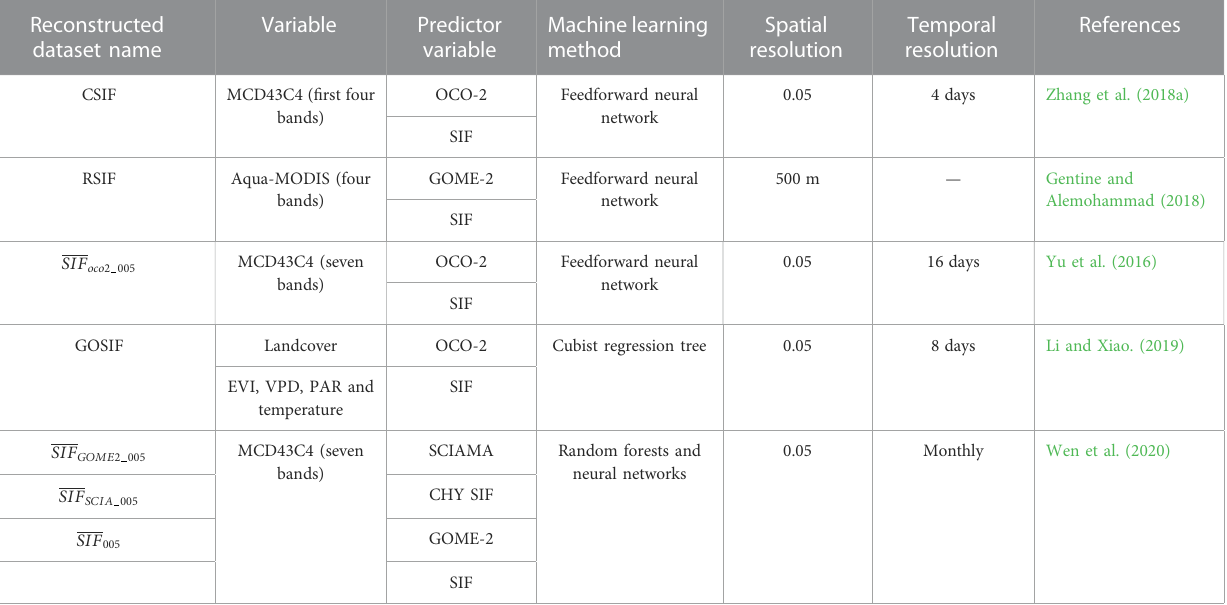
TABLE 4 Comparison of reconstructed SIF